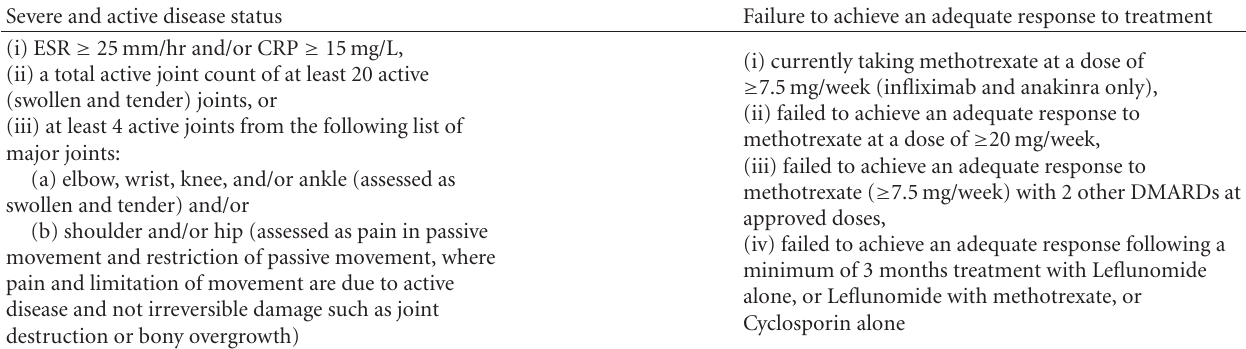
Table 1: Disease status and treatment response criteria needed to be met by Australian patients in order to receive government-subsided